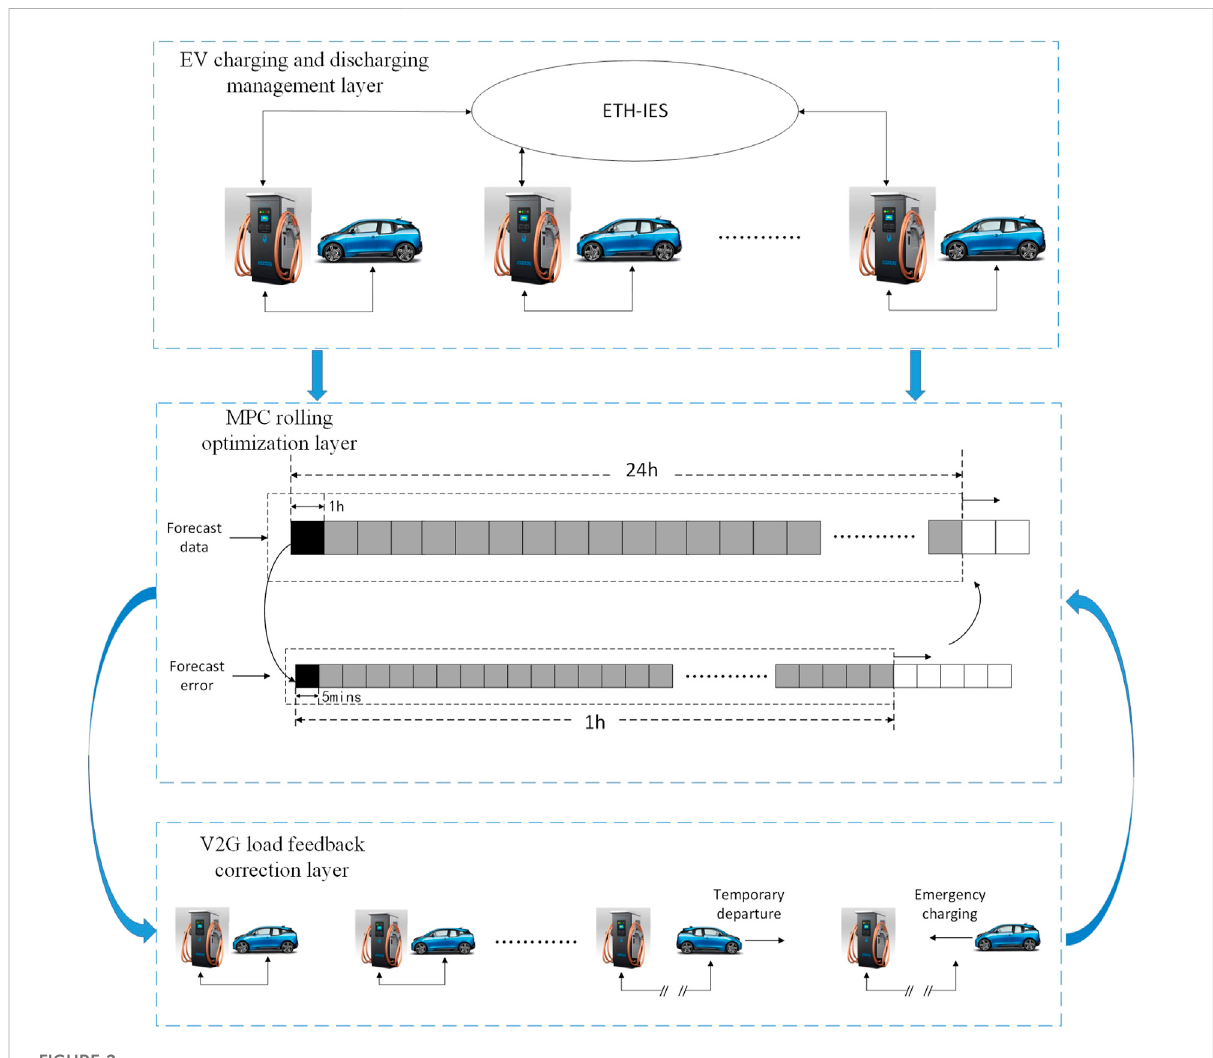
FIGURE 2 ETH-IES multi-layer coordinated optimization